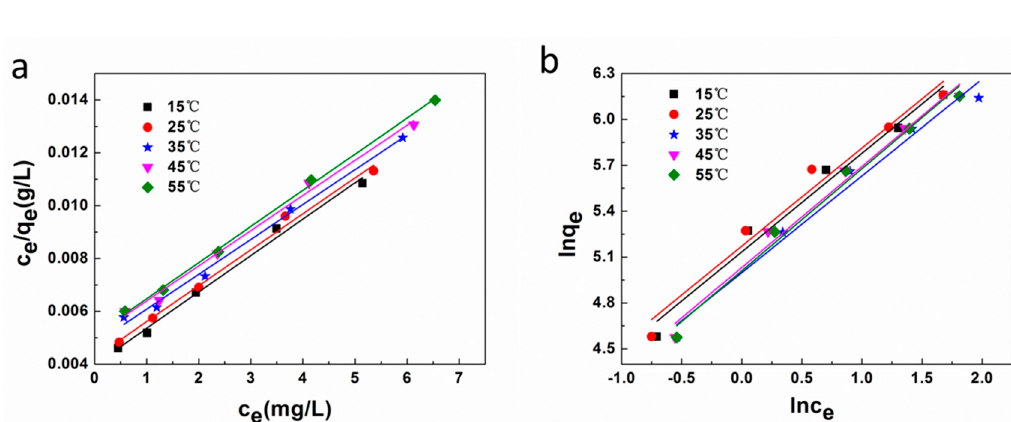
Figure 8. ( a ) Langmuir and ( b ) Freundlich isotherms for the adsorption of MB by CNC-g-AA-2-120-8 aerogels at different temperatures. Table 2. Adsorption isotherm parameters for MB adsorption of CNC-g-AA aerogels. Langmuir